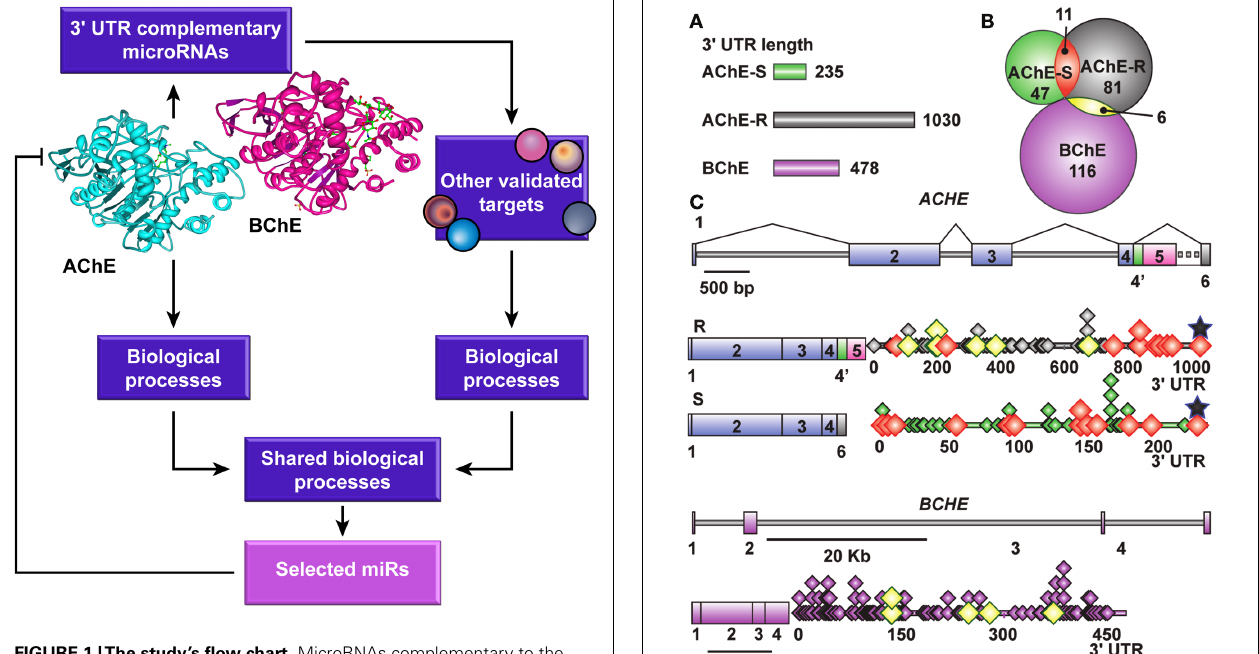
FIGURE 1 |The study’s flow chart. MicroRNAs complementary to the 3 (cid:2) -UTR domains of AChE and BChE transcripts were identified using several algorithms and other validated targets for those miRs were searched for and analyzed for common biological processes in which both these miR targets and cholinesterases are involved.